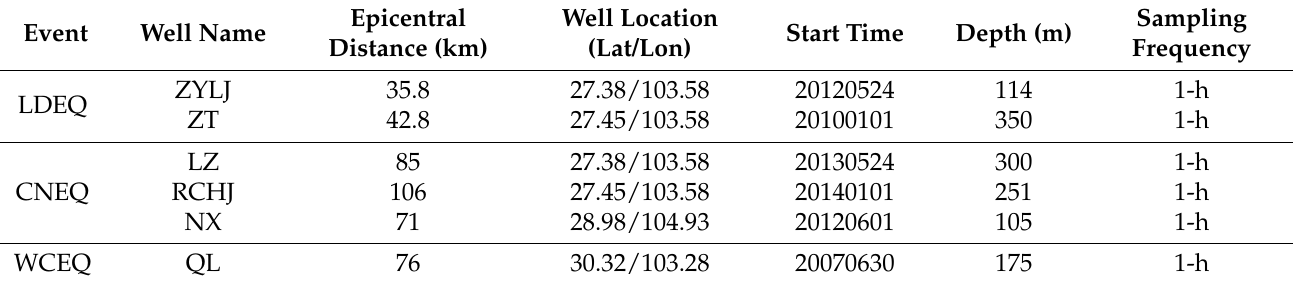
Table 1. Detailed information of the well water level adopted for LURR